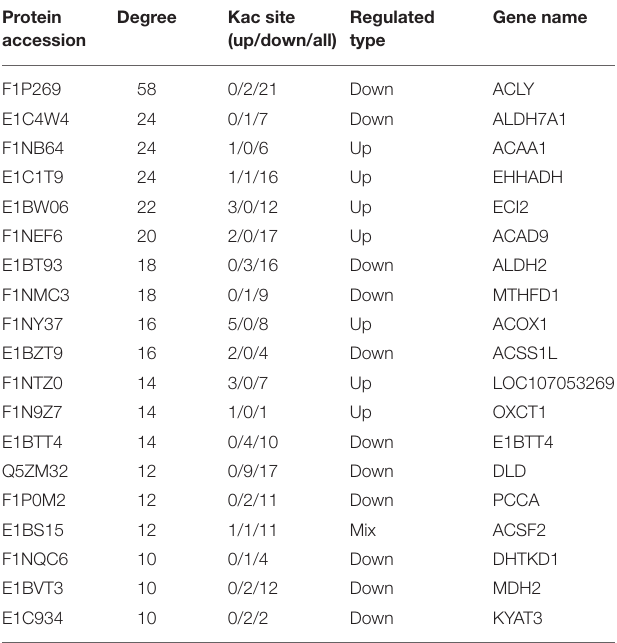
TABLE 2 | Top 20 hub-proteins in PPI network. Protein